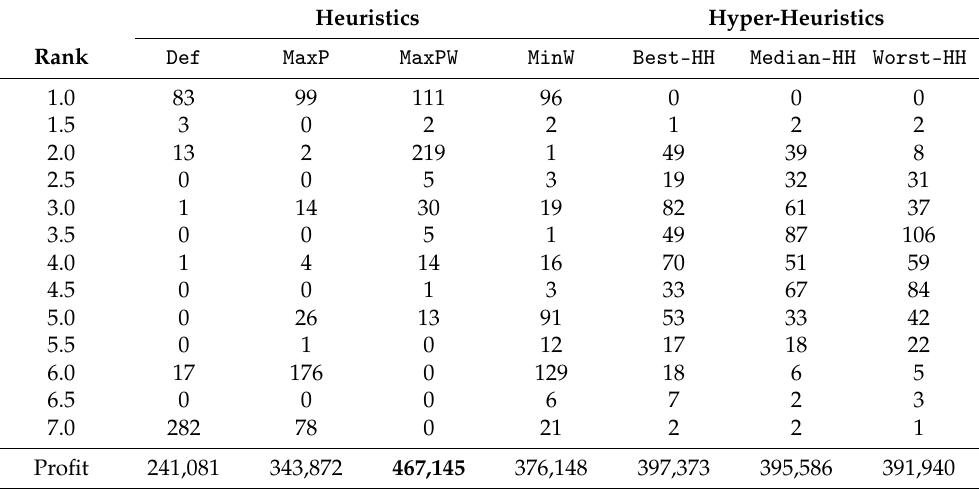
Table 6. Ranks and total profit obtained by the four heuristics and the best, median, and worst hyper- heuristics trained on set α 1 and tested on set α 2 , but MaxPW is not available for the hyper-heuristics. The best result, measured in terms of total profit, is highlighted in bold.